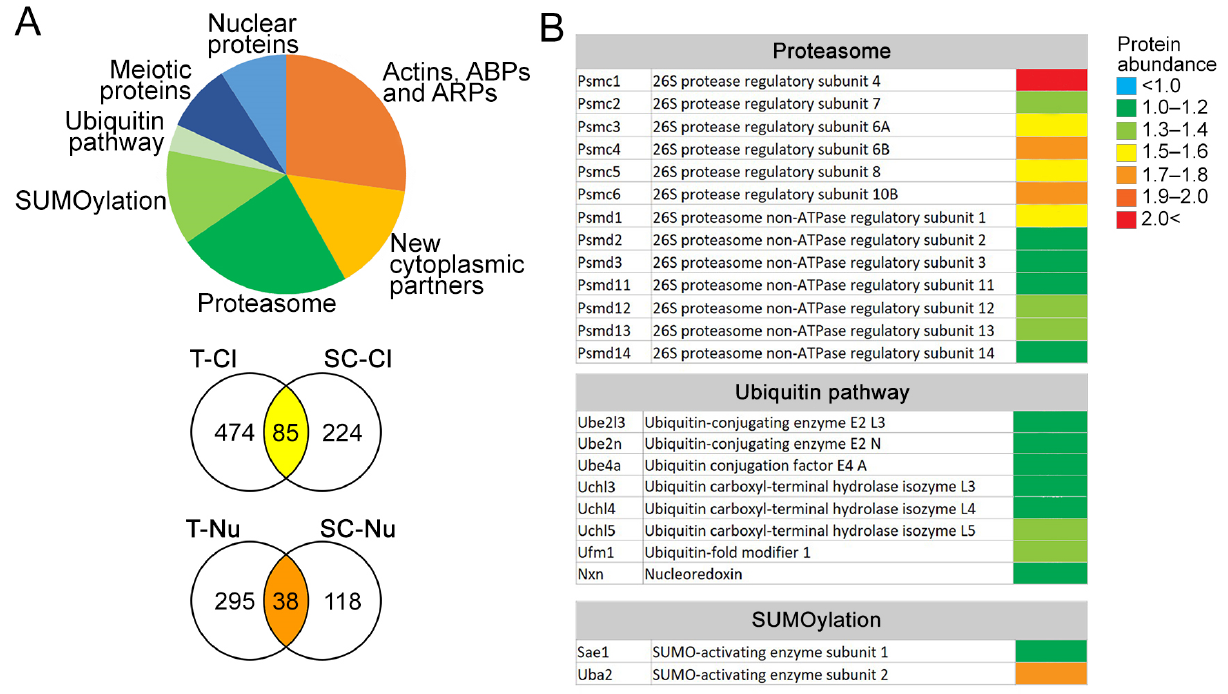
Figure 8. VCL interacted with the components of UPS in meiocytes; ( A ) the graph depicts the group of proteins co-IP-ed with VCL. The number of identified proteins is indicated in the circles, and proteins were found in both sets, i.e., we found 85 common proteins in the cytoplasmic fraction and 38 proteins in the nuclear fractions. These proteins were significantly abundant in the cytoplasmic (Cl) and nuclear extracts (Nu) in both testicular single-cell suspension and FACS-sorted pachytene spermatocytes. The biggest portion of interacting partners were from the cytoskeleton and cytoplasm. However, the majority of the proteins belonged to the UPS; ( B ) the list of co-IP-ed proteins consists of proteasome and its subunits, ubiquitination, and the SUMOylation pathway. Here, only the most abundant proteins are shown. The heat map indicates enrichment (log-fold change) of the representative protein in the co-IP experiment compared to the isotype control